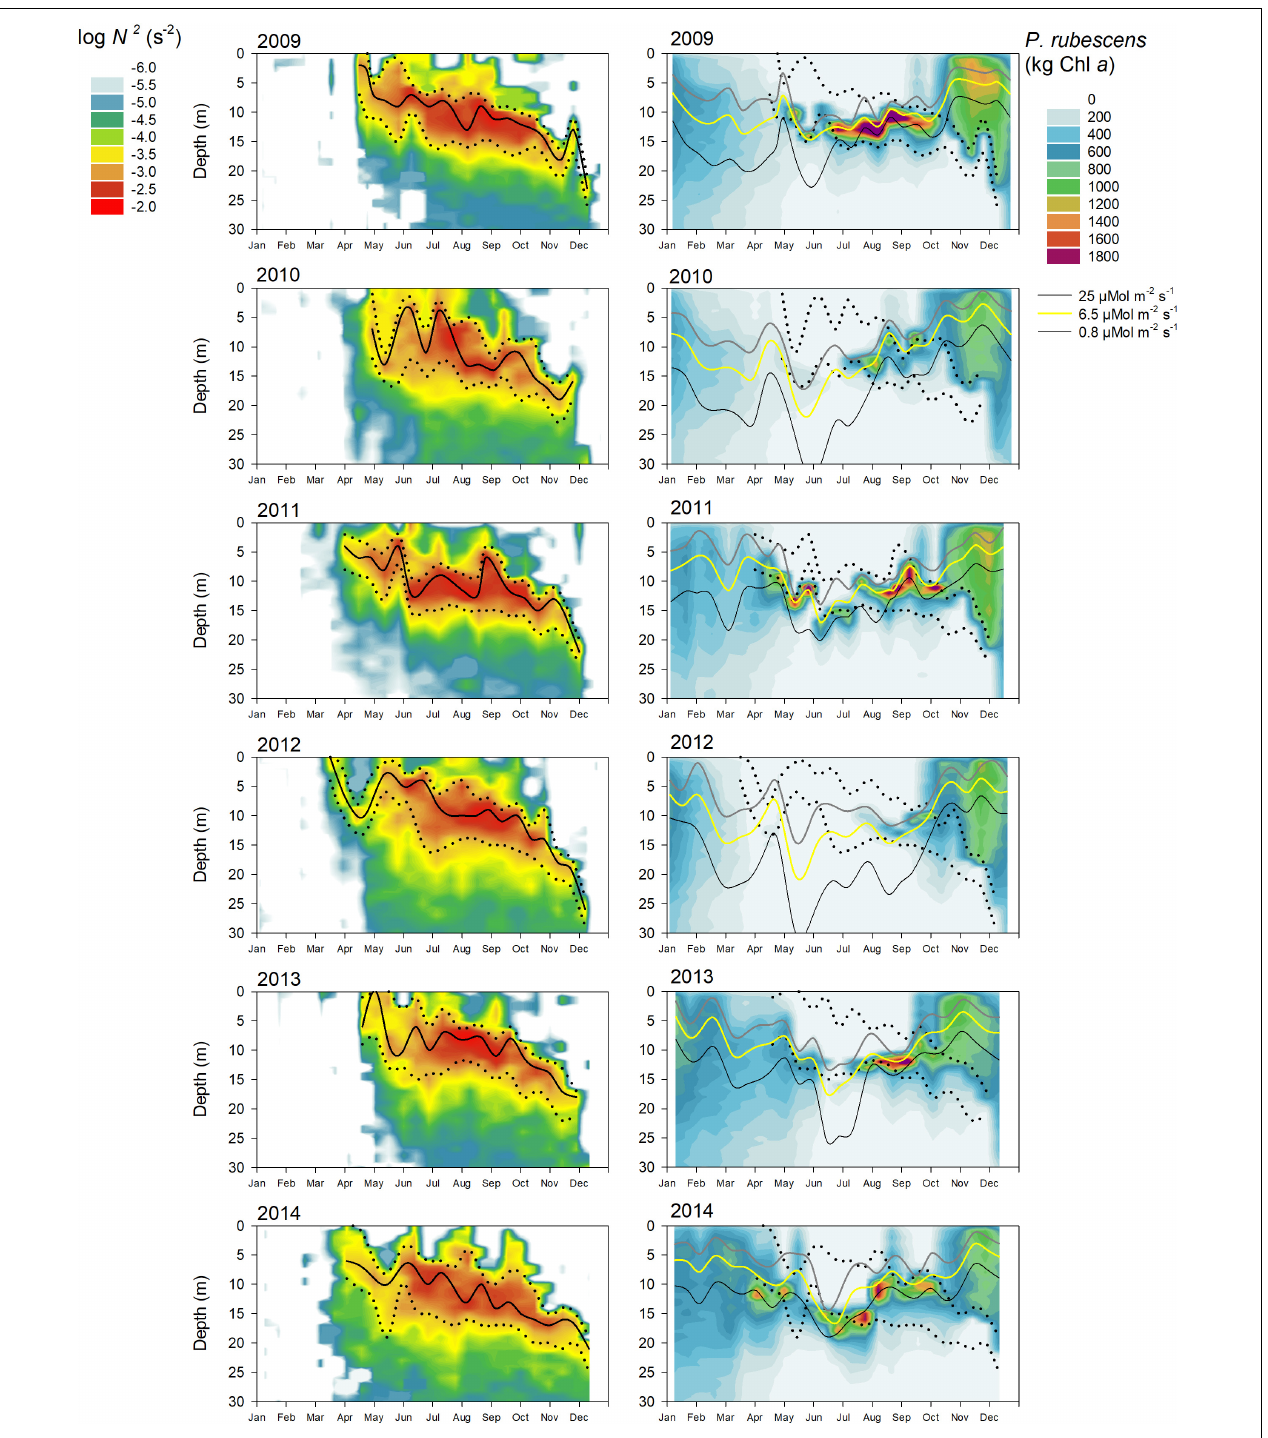
FIGURE 5 | Relationship between water column stability N 2 , light intensity, and the cumulative P. rubescens biomass for the upper 30 m water column from 2009 to 2014 in Lake Zurich. Left panels: seasonal development of the upper and lower boundary of the metalimnion (black dotted line) as well as the depth of the metalimnetic center (black solid line, depth where N 2 reached highest value). Right panels: three P. rubescens relevant irradiances resulting in neutral buoyancy ( z buoy where E d = 6.5 µ mol m – 2 s – 1 , yellow solid line), buoyancy loss ( z sat where E d = 25 µ mol m – 2 s – 1 , gray solid line), or buoyancy gain ( z comp where E d = 0.8 µ mol m – 2 s – 1 , black solid line). Cumulative P. rubescens biomass (kg in vivo chlorophyll a per 1 m depth step) and the upper and lower boundary of the metalimnion (black dotted lines). All data are based on biweekly measurements in 1 m depth intervals. The exact depths of the three intrinsic irradiance values were calculated from PAR profiles in 1 m depth intervals from surface down to the depth with an irradiance of > 0.05 µ mol m – 2 s – 1 .